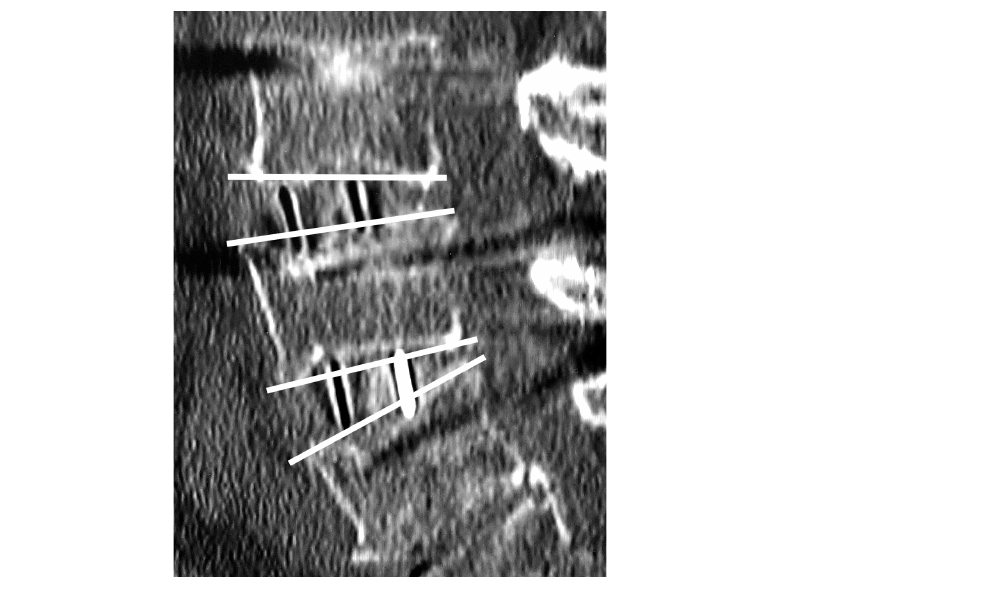
Figure 5. Vertebral endplate concavity (VEC) and cage subsidence. Both cages exceeded the end plates by ≥ 1 mm (VEC-positive) with Marchi classification grade 0.